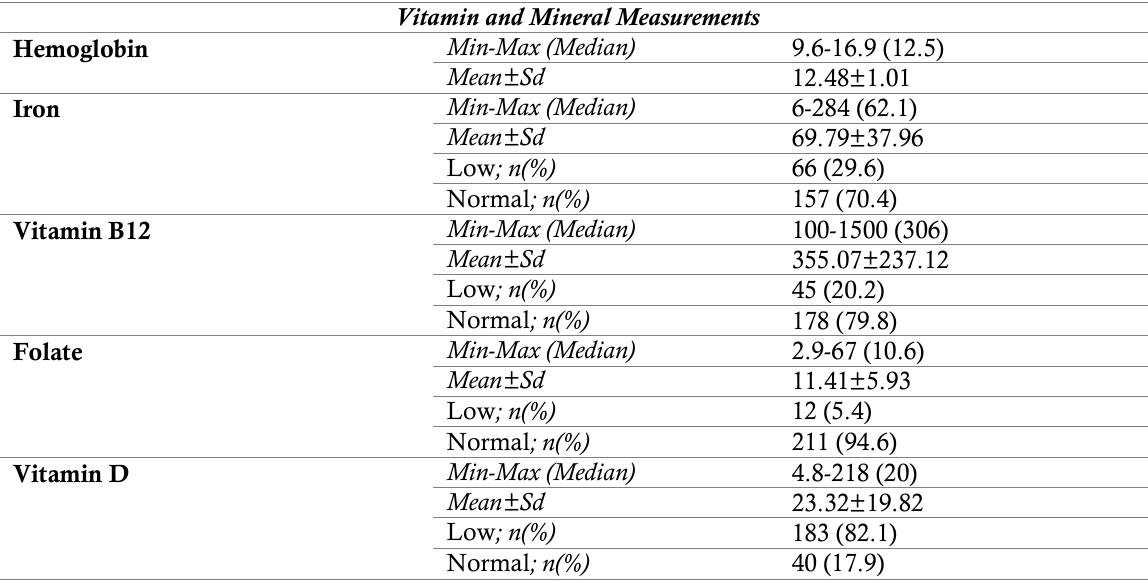
Table 2 . Distribution of Vitamin and Mineral Measurements